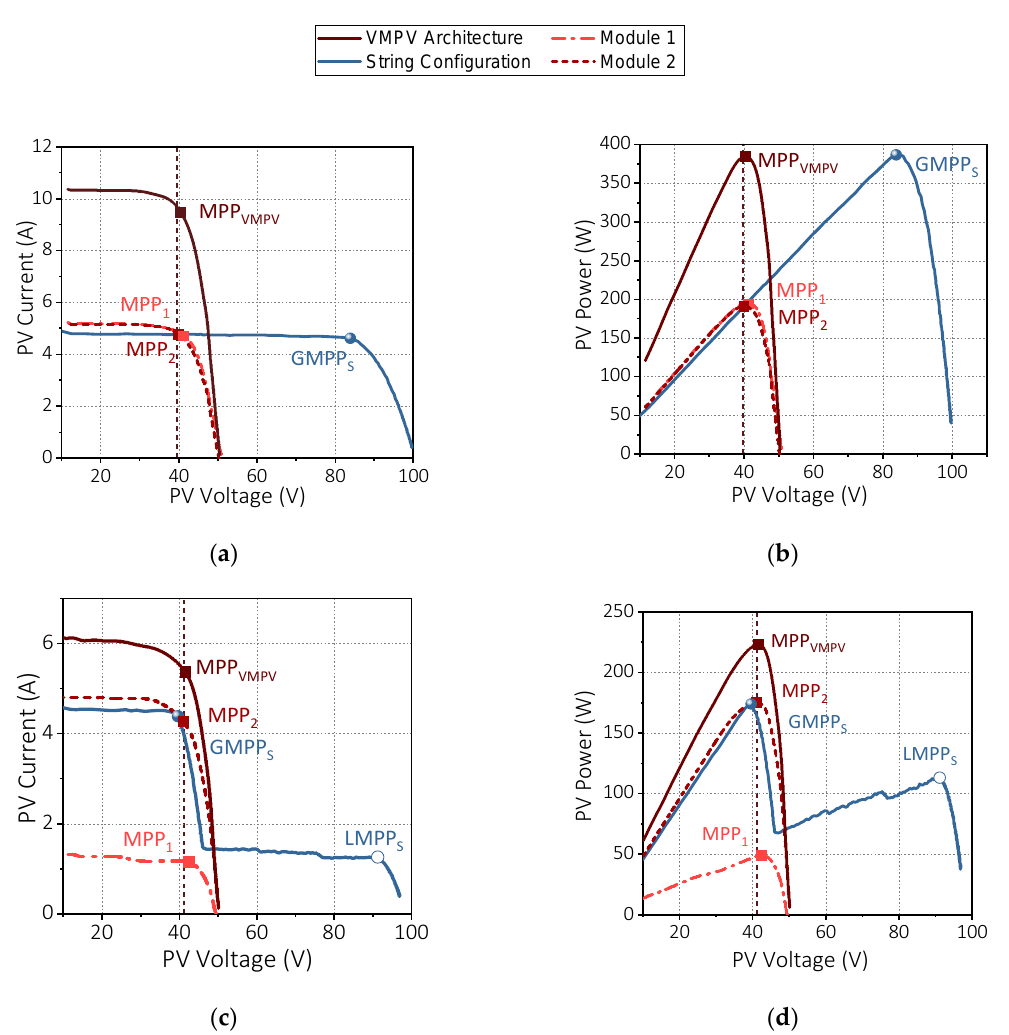
Figure 12. Experimentally extracted I-V and P-V characteristics of the PV modules under ( a , b ) the shading pattern A: uniform irradiance and ( c , d ) the shading pattern B: PS conditions. Table 2. MPP data from the experimentally extracted